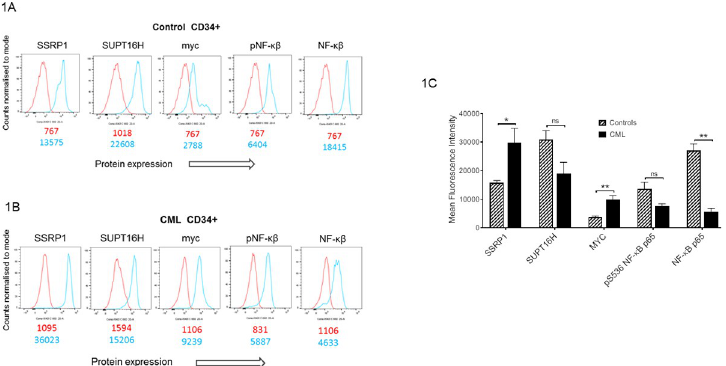
Fig 1. The expression of targets of CBL0137 are perturbed in patients with CML. CD34 + cells were enriched from control (Fig 1A) and CML patients (Fig 1B) using CliniMACS (Miltenyi Biotec) and stained with the antibodies to the proteins shown and expression levels analysed on a Novocyte flow cytometer (ACEA Biosciences) using FloJo software. Representative FACS plots are shown (Fig 1A and 1B) with staining with secondary antibody alone illustrated in blue and the staining achieved with the primary antibody shown in red. Amalgamated data (Fig 1C) is displayed as median fluorescent intensity ± SEM (n = 4–5 for healthy controls, n = 3 for CML).